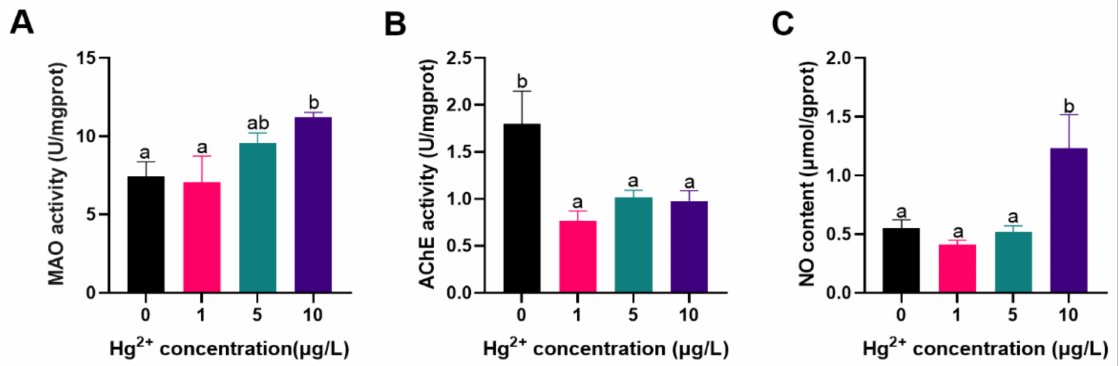
Figure 2. Response to the neurotoxic related parameters of silver carp larvae exposed to Hg 2+ ( A ) MAO activity; ( B ) AChE content; ( C ) NO content. Vertical bars represent the mean ± SE ( n = 3). Different letters indicate significant differences between groups ( p < 0.05).